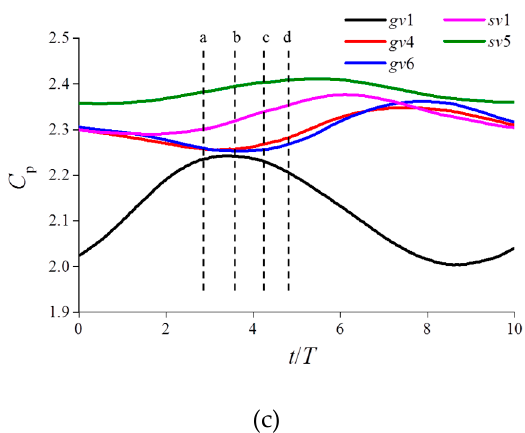
Figure 23. Pressure coefficient analysis. ( a ) Locations of monitoring points in the guide vane and stay vane channel, ( b ) time history of C p at gv 1 at condition V by black line while the red line is the low-pass filtered signal of black line as well as ( c ) low-pass filtered signal of C p at these points and four time instances.